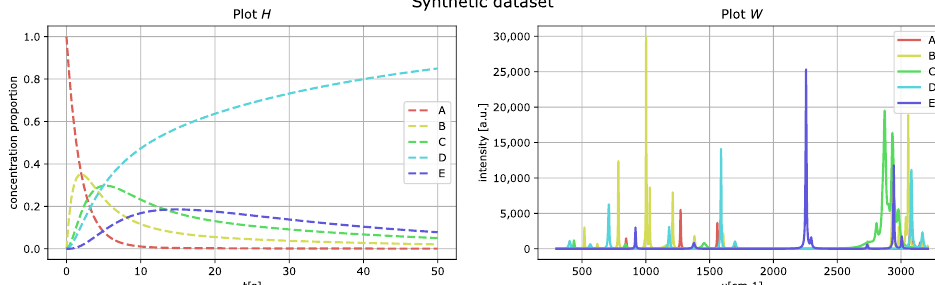
Figure 3. First-order-kinetics reaction of five spectral compounds ( A , B , C , D , and E ) generating the dataset in Section 4.1. The ( left figure ) shows the time development of the concentration proportions, and the ( right figure ) displays the spectral fingerprints of the